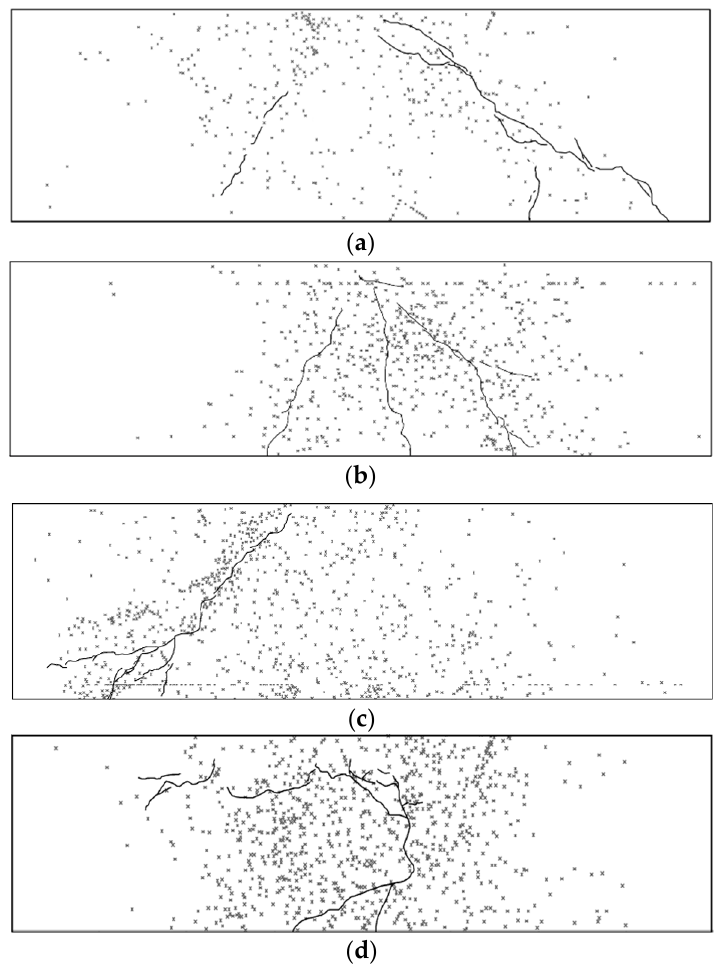
Figure 11. Localization of AE events and cracks: ( a ) Uncorroded RC beam; ( b ) 10% corroded RC beam; ( c ) 20% corroded RC beam; ( d ) 30% corroded RC beam.